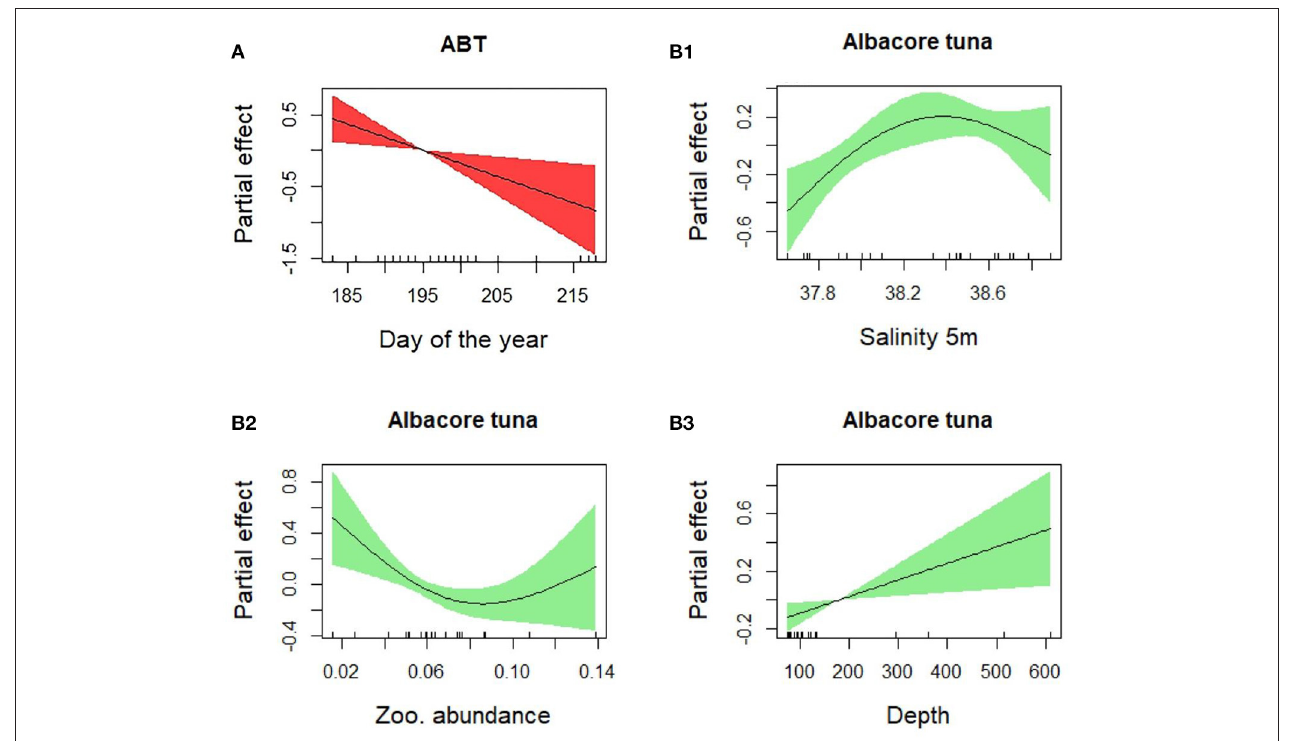
FIGURE 6 | Results of the generalized additive abundance models for (A) bluefin tuna and (B1, B2, B3) albacore